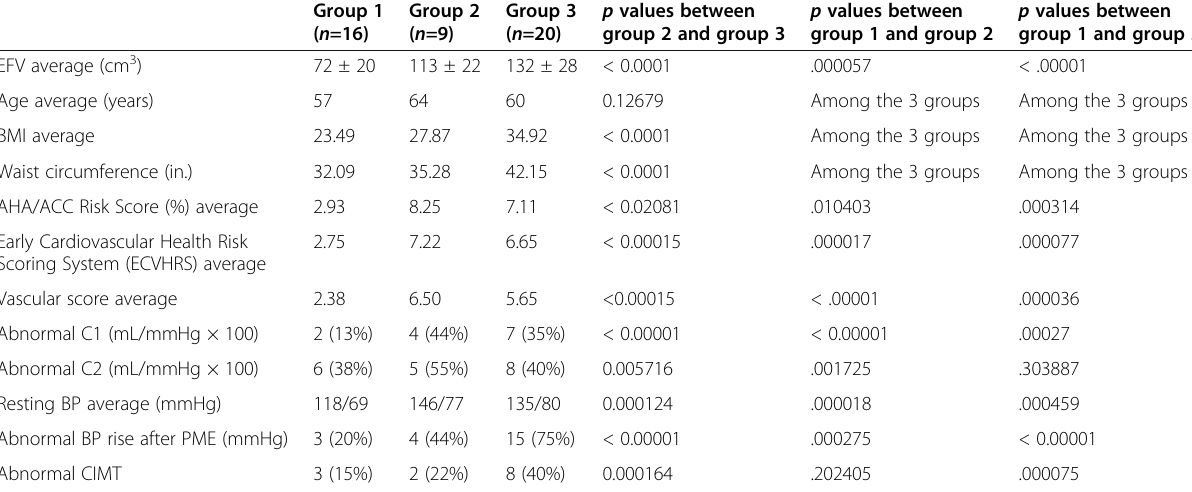
Table 1 EFV and cardiovascular abnormalities score in study groups